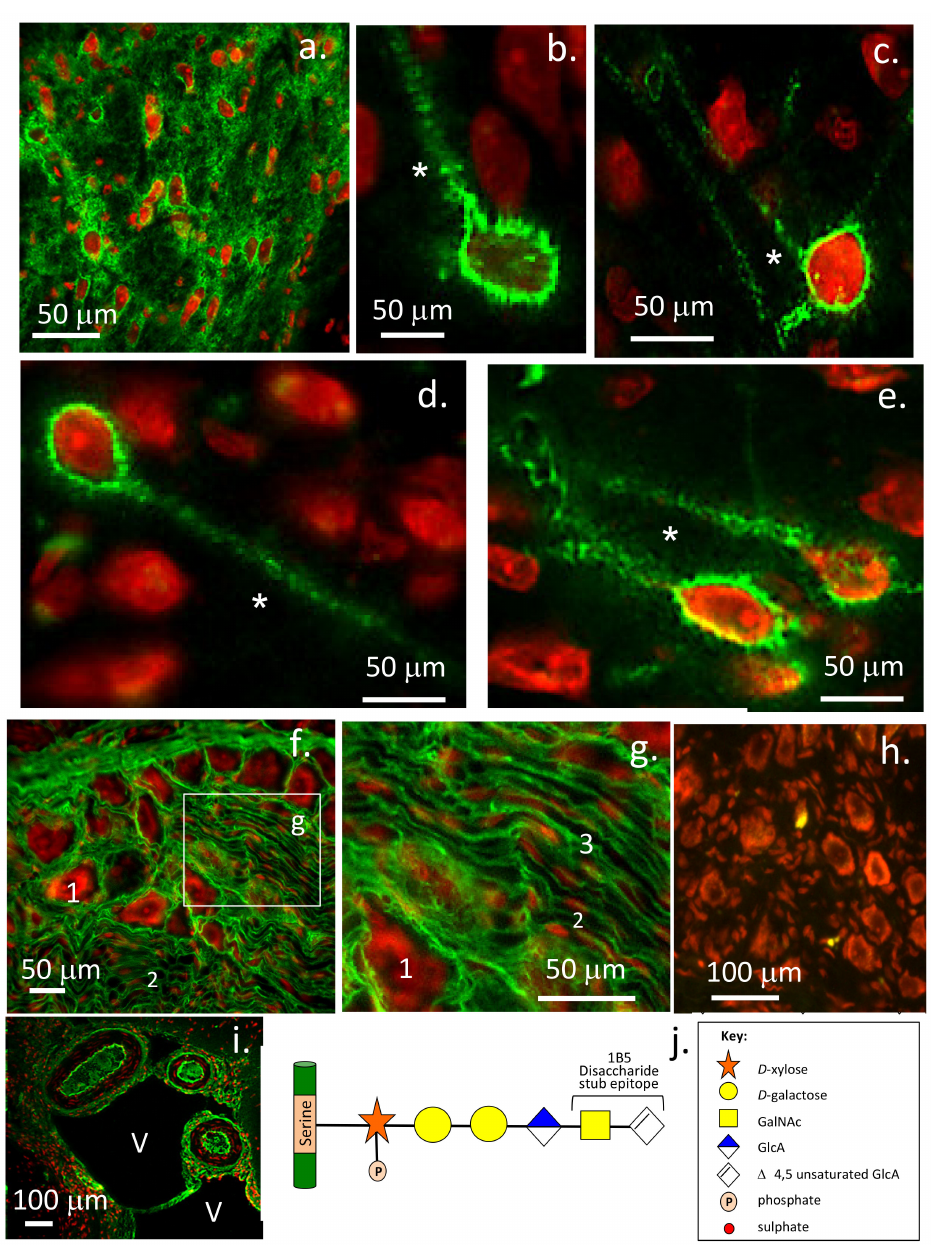
Figure 7. Immunolocalisation of the lectican CS-PGs using monoclonal antibody 1B5. The lectican PGs form diffuse assemblies in the brain ECM between the perineuronal nets (PNNs), as well as denser ECM in the PNNs. Lectican localisation is prominent in the cerebrum and pre-frontal cortex ( a ), but is less prominent in the PNNs of the sub-ventral cortex ( b – e ). Lectican PGs are also prominent components of neural tissue in the dorsal root ganglion surrounding the larger sensory neurons (1) and smaller satellite cells (2), as well as lamellar neural structures (3) ( f , g ) and ventricle-associated cerebral vessels in the arachnoid mater ( i ). Speckled 1-B-5 +ve dendritic processes typical of fractone stem cell niches are labelled with an asterisk (*). A negative control tissue section of the dorsal root ganglion is also shown ( h ). A schematic of the epitope identified by monoclonal antibody 1B5 is depicted in ( j ). This 1B5 epitope is generated by pre-digestion of tissue sections with chondroitinase ABC (0.1 U/mL) for 1 h at 37 ◦ C in Tris-HCl pH 7.2. Images supplied by Prof B. Caterson, University of Cardiff, Cardiff, UK. Images © Caterson and Hayes